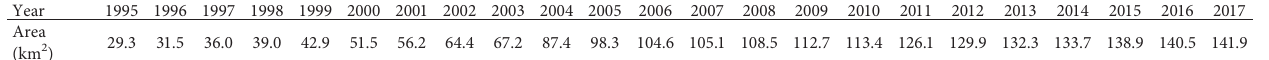
Figure 4: Display of different remote sensing Table 2: The area of the industrial land in Shunde from1995 to 2017.